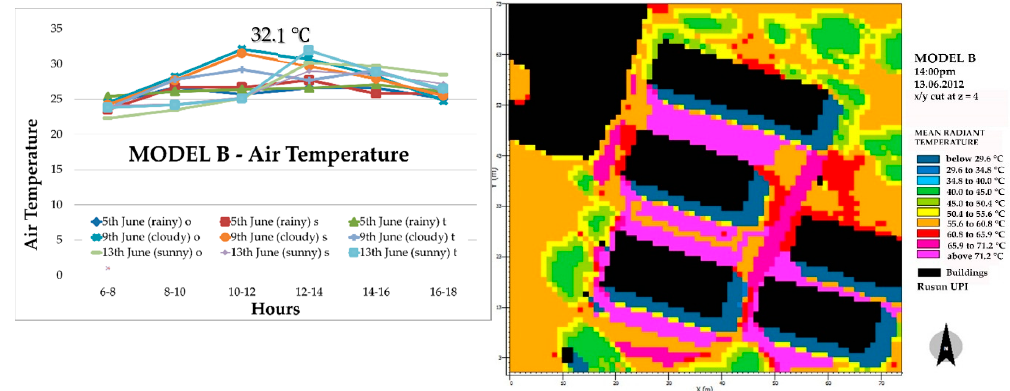
Figure 6. Model C—Interspersed Plot Microclimate.